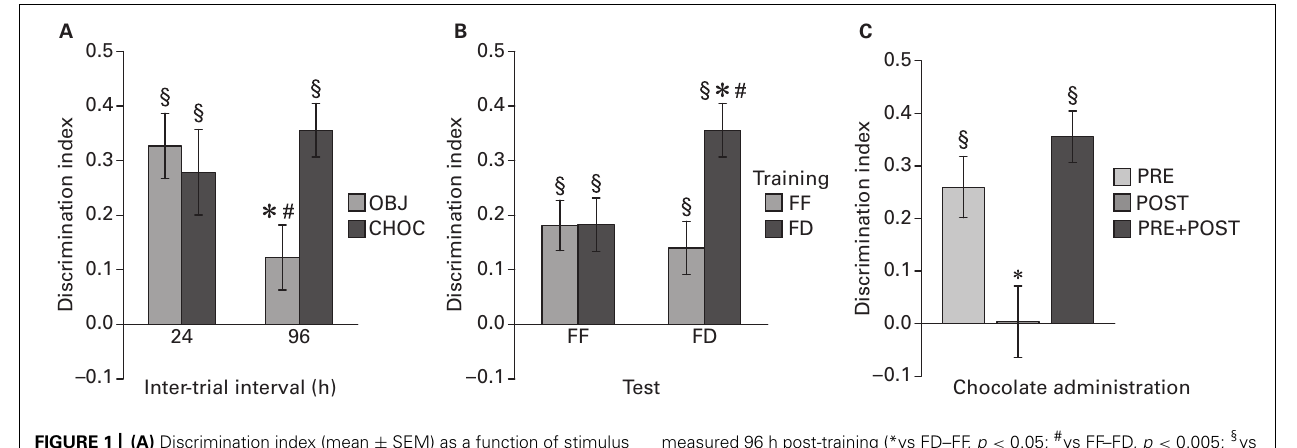
measured 96 h post-training (*vs FD–FF, p < 0.05; # vs FF–FD, p < 0.005; § vs 0, p < 0.0001); (C) Discrimination index (mean ± SEM) as a function of chocolate administration protocol measured 96 h post-training (*vs all, p < 0.05; § vs 0, p < 0.01).